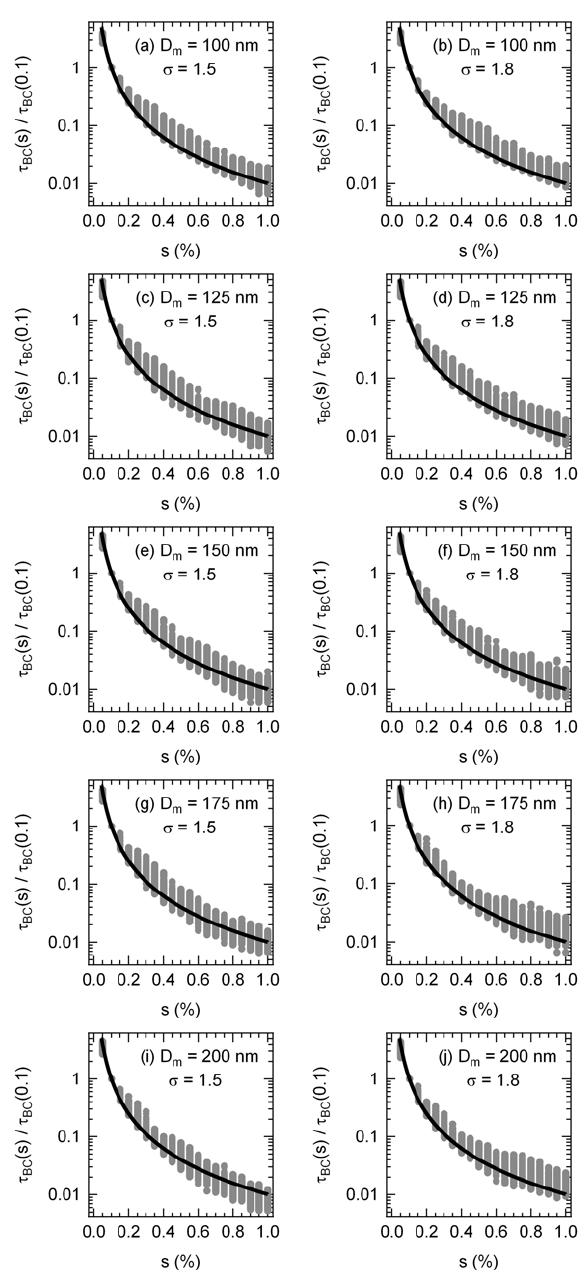
Fig. B1. Comparisons of the F(s) ( ≡ τ BC (s) / τ BC (0.1)) values as a function of s (supersaturation, %) calculated by Eq. (B1) (black curves) with the τ BC (s) / τ BC (0.1) values derived from the calcula- tion results using all combinations of the initial parameters shown in Table 1 between 0.05% and 1% with a 0.05% interval (gray cir- cles) for each given lognormal BC size distribution shown in Fig.